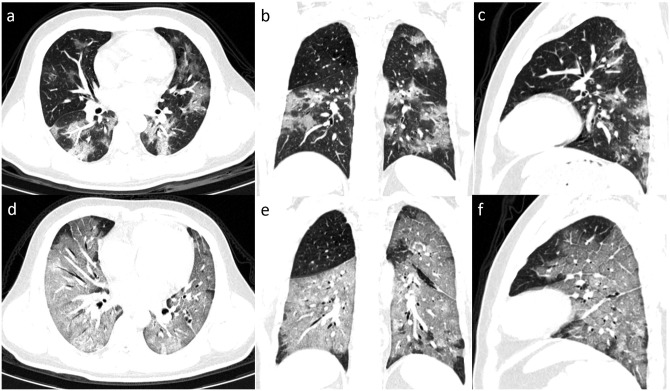
Serial chest images of a 33-year-old man with fever and dyspnea.(a-d) 16 days before death, chest CT with axial, coronal, sagittal planes showed moderate lung involvement with a total CT score of 11, appearing as ground-glass opacities (GGOs) with patches of consolidation in bilateral lungs. (e-f) 12 days before death, chest CT with different planes showed severe lung involvement with a total score of 19, appearing as diffusion GGOs with consolidation (white lung).